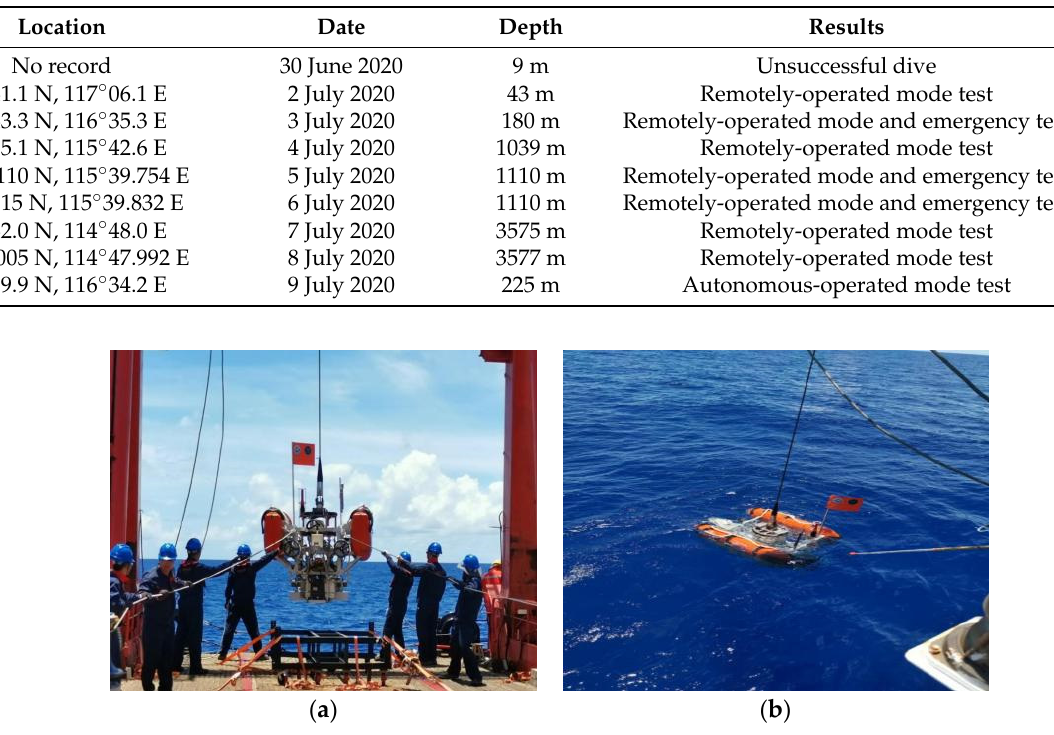
Figure 23. ( a ) Launching ARV using LARS system; ( b ) ARV on the water surface before disconnection.